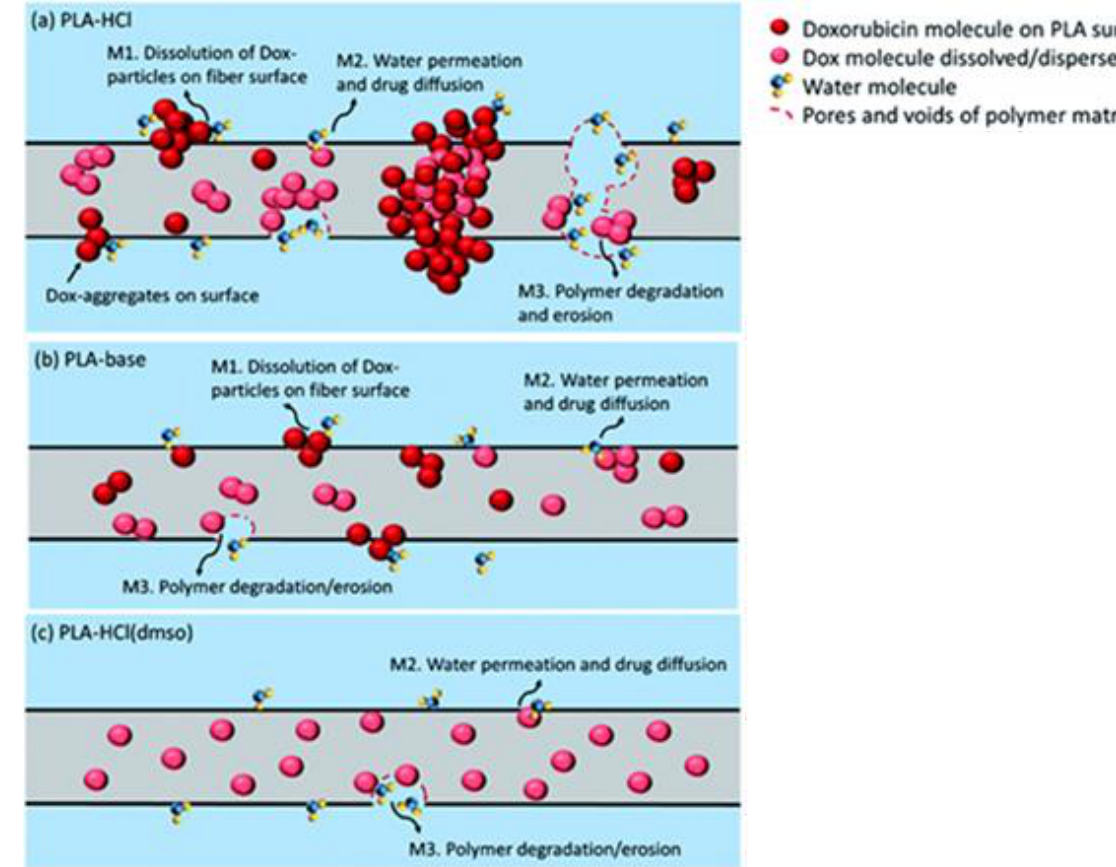
Figure 14. Illustration of doxorubicin drug release mechanisms from a PLA fiber matrix. ( a ) PLA– HCl; ( b ) PLA–base; ( c ) PLA–HCl (DMSO). M1, dissolution of drug molecules; M2, water